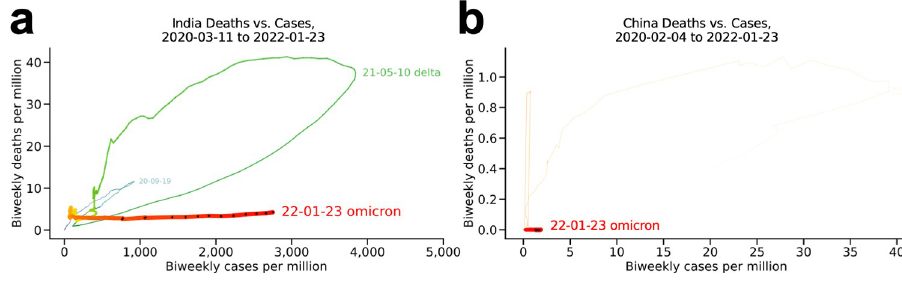
Fig 5. India and China. (a) India and (b) China. The two most populous countries.